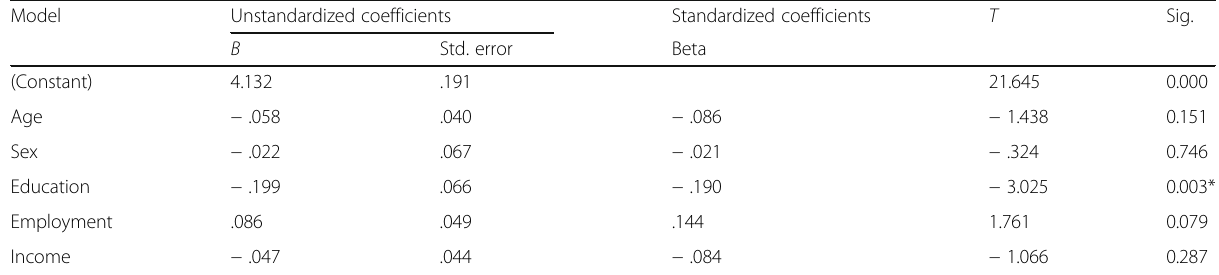
Table 5 Linear regression between patients ’ demographic variables and total score of marketing